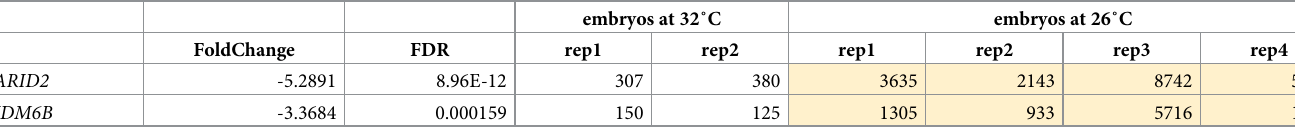
Table 3. Estimated read counts for JARID2 and KDM6B (differentially expressed isoforms).